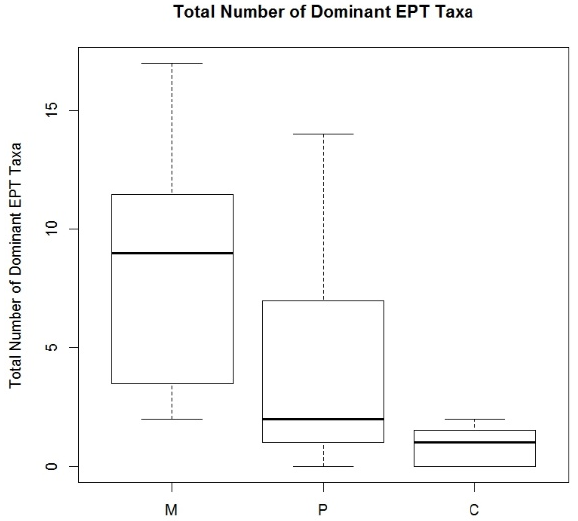
Figure 5. Total Number of Dominant EPT Taxa for mountain (M), Piedmont (P), and coastal plain (C) streams ( n =